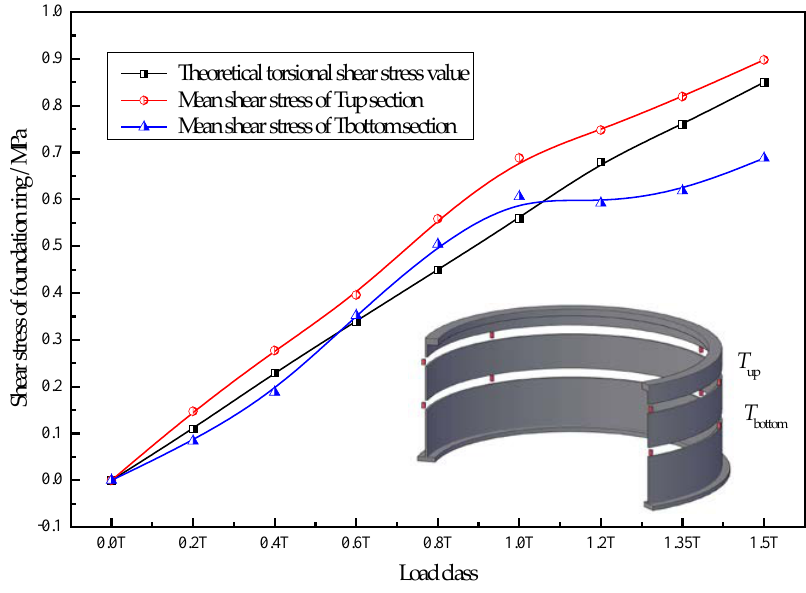
Figure 12. Torsional shear stress on the foundation ring of ZT-3.